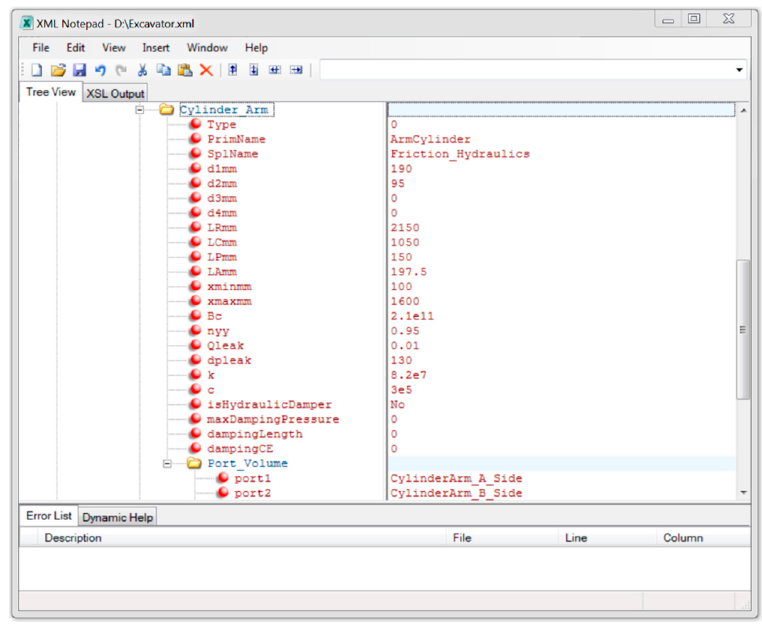
Figure 8. Sample XML file structure for the arm-attached hydraulic actuator.